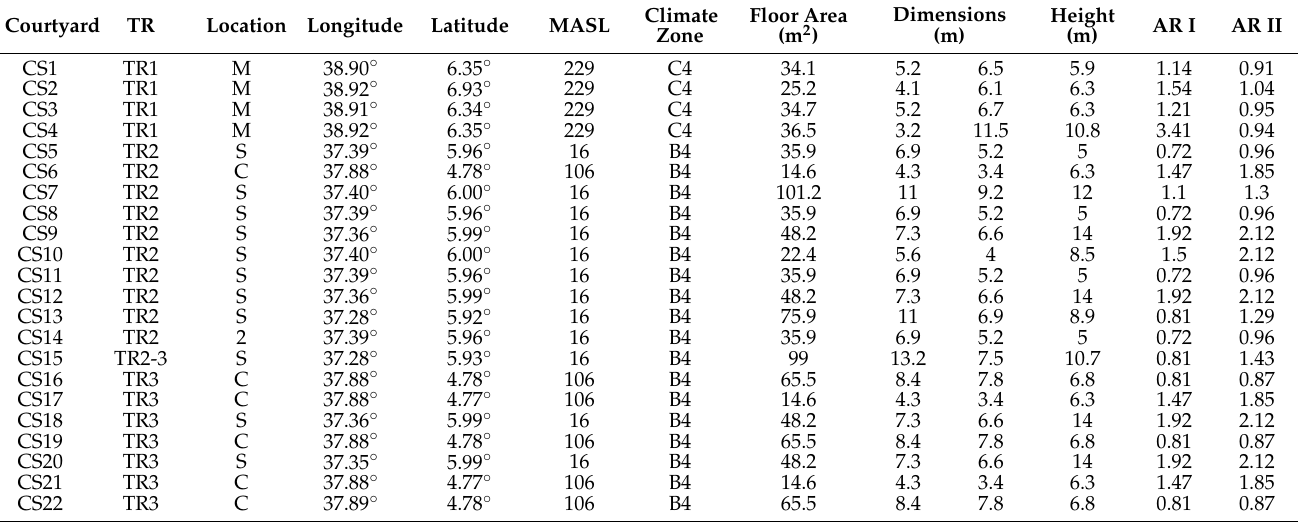
Table 1. Location of monitored courtyards in this